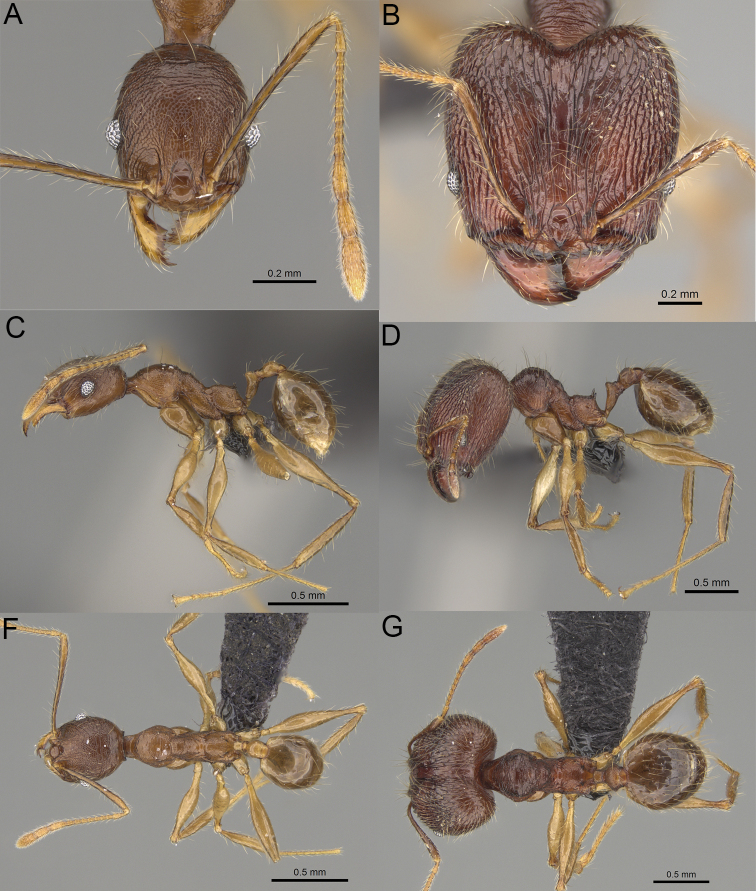
Pheidole
mahamavo sp. nov., full-face view (A), profile (C), and dorsal view (E) of paratype minor worker (CASENT0455922) and full-face view (B), profile (D), and dorsal view (F) of holotype major worker (CASENT0923292).